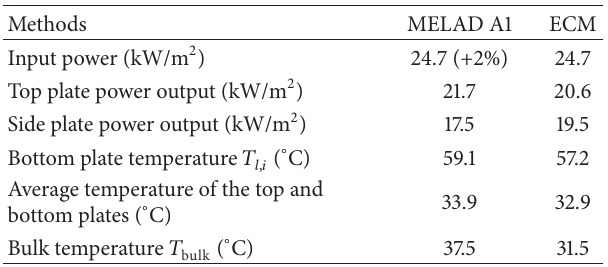
Table 2: MELAD A1 experiment [8] versus ECM prediction energy splitting and temperature.